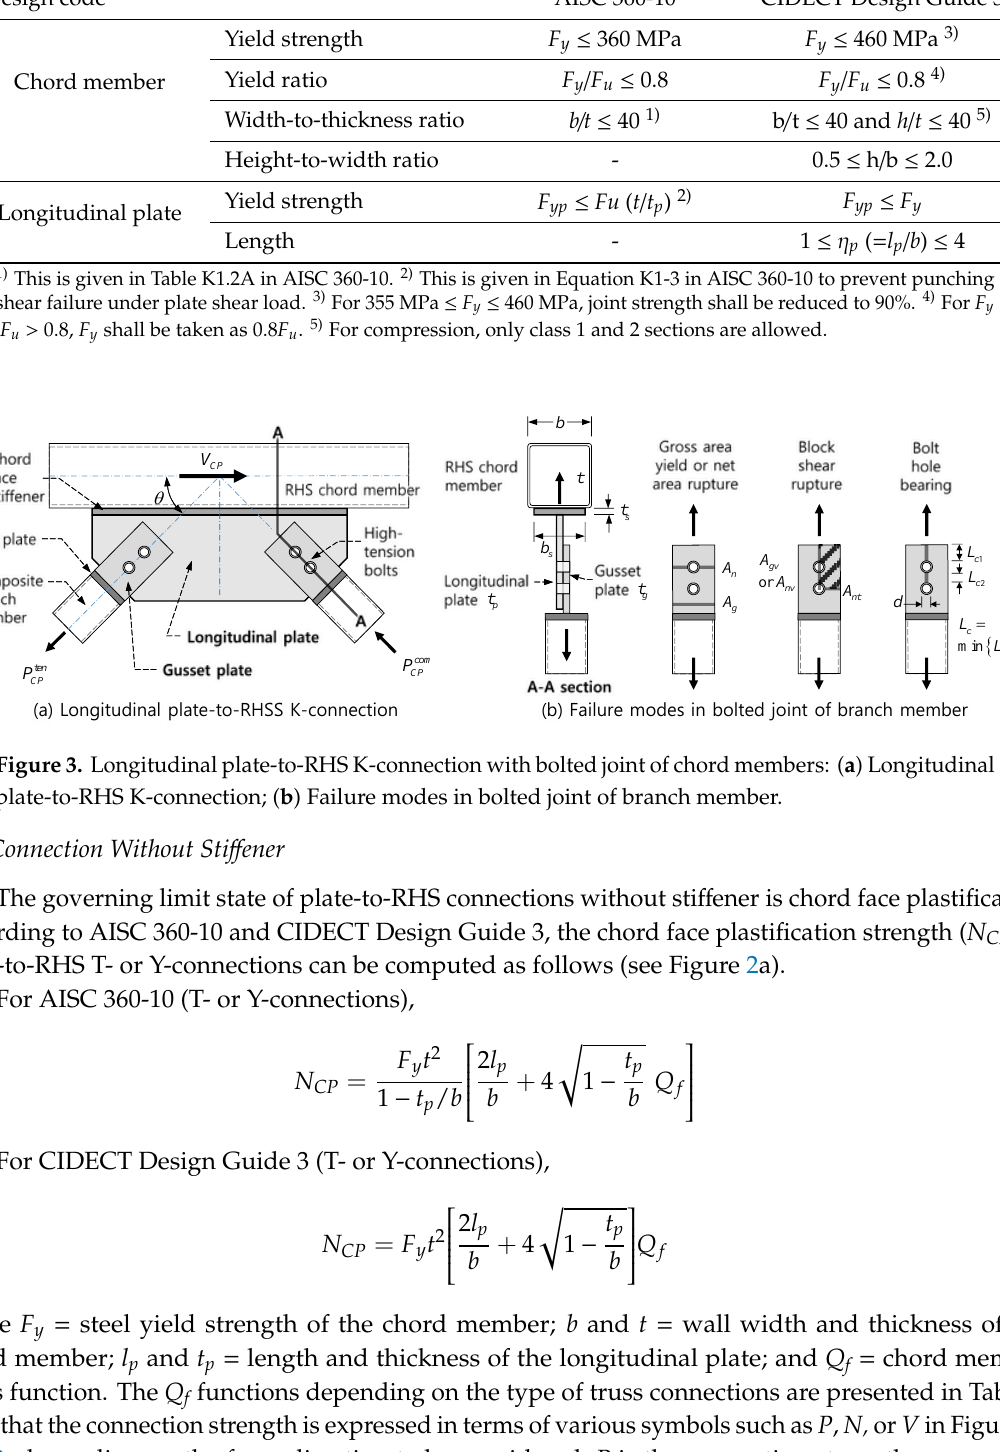
Table 2. Chord member stress functions Q f for RHS truss T-, Y-, and K-connections.